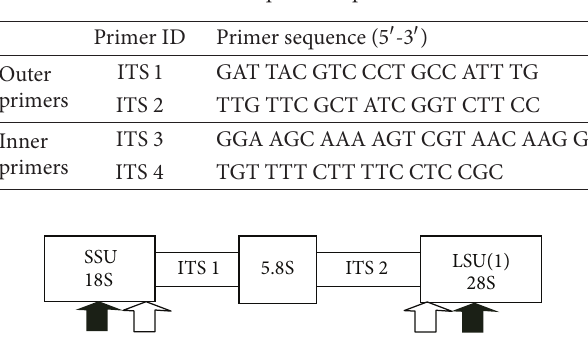
Figure 3: Schematic diagram of rDNA showing ITS 1 and ITS 2 annealing positions